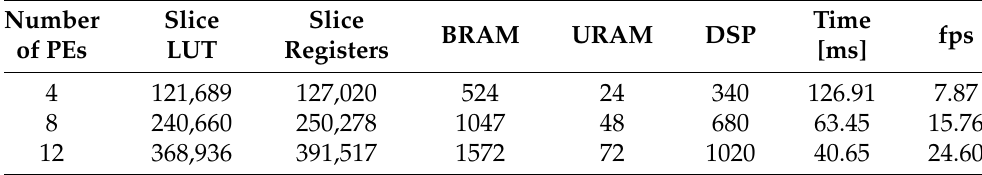
Table 10. Resource utilization and inference time on an XCZU19EG FPGA for different numbers of